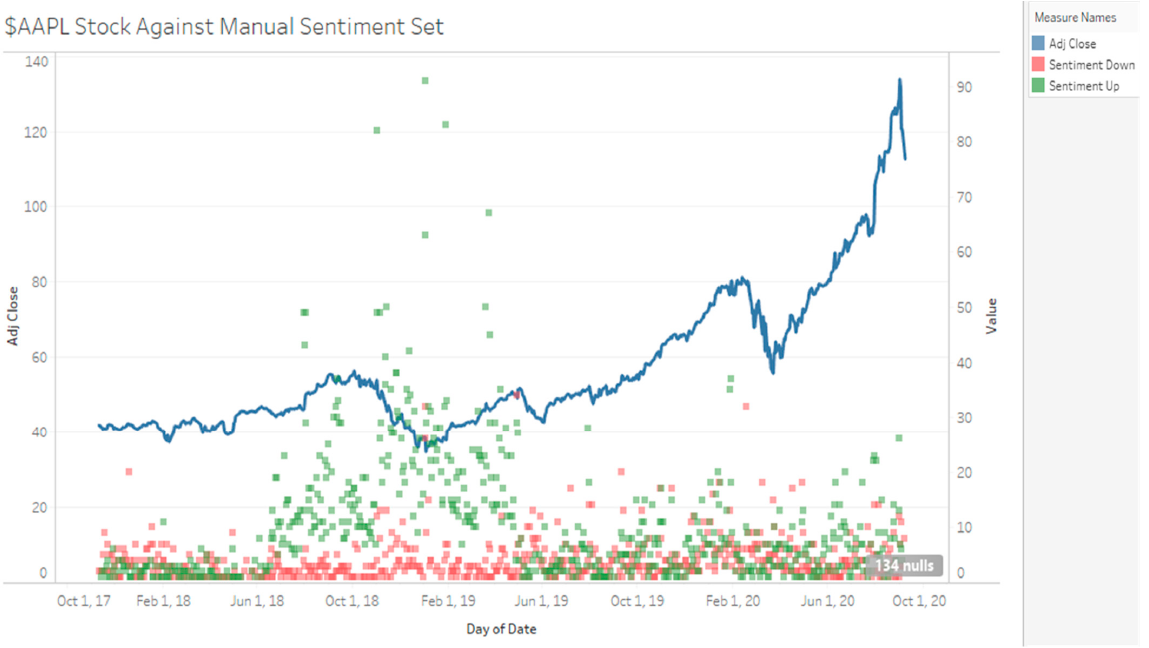
Figure 4. AAPL Stock Against Manual Sentiment.